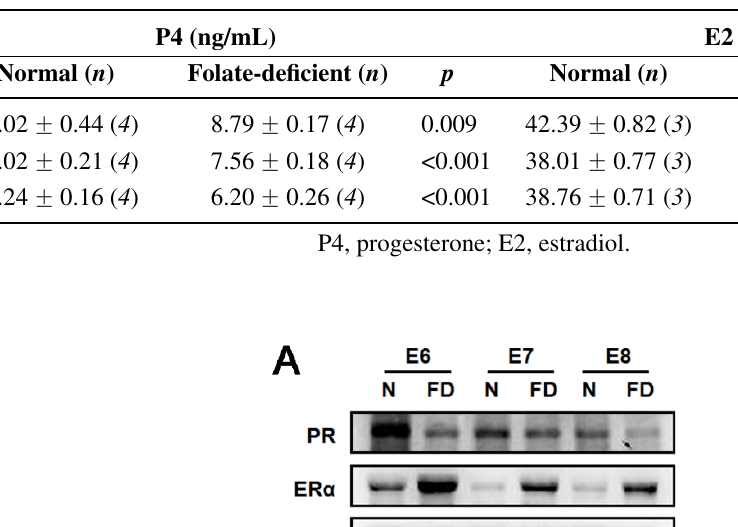
Table 5. Serum FSH, LH, and PRL levels in the pregnant mice (mean ± standard error of the mean (SEM)). LH (mIU/mL)